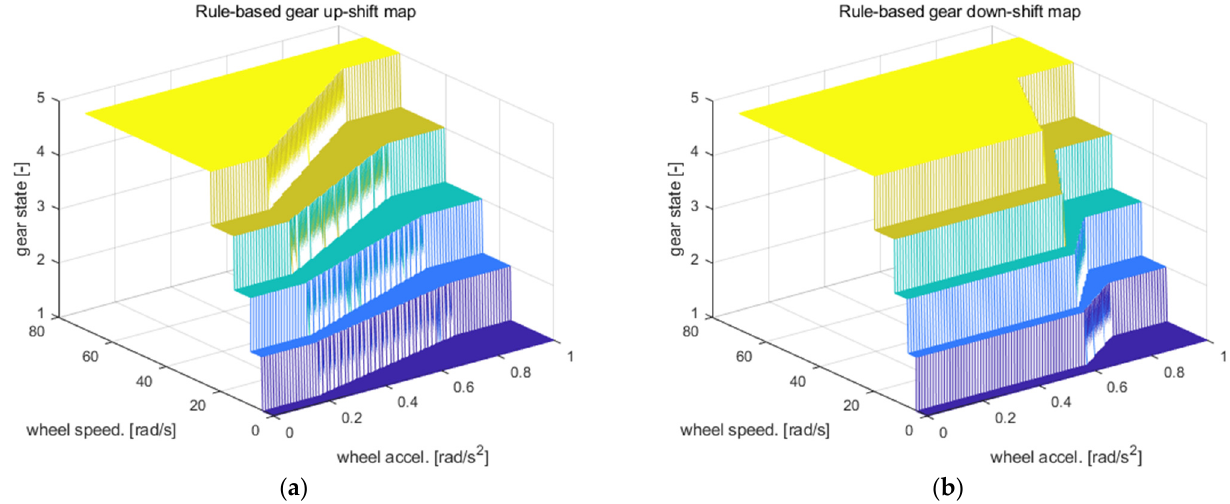
Figure 5. Gear shift rule. ( a ) Upshift map. ( b ) Downshift map.